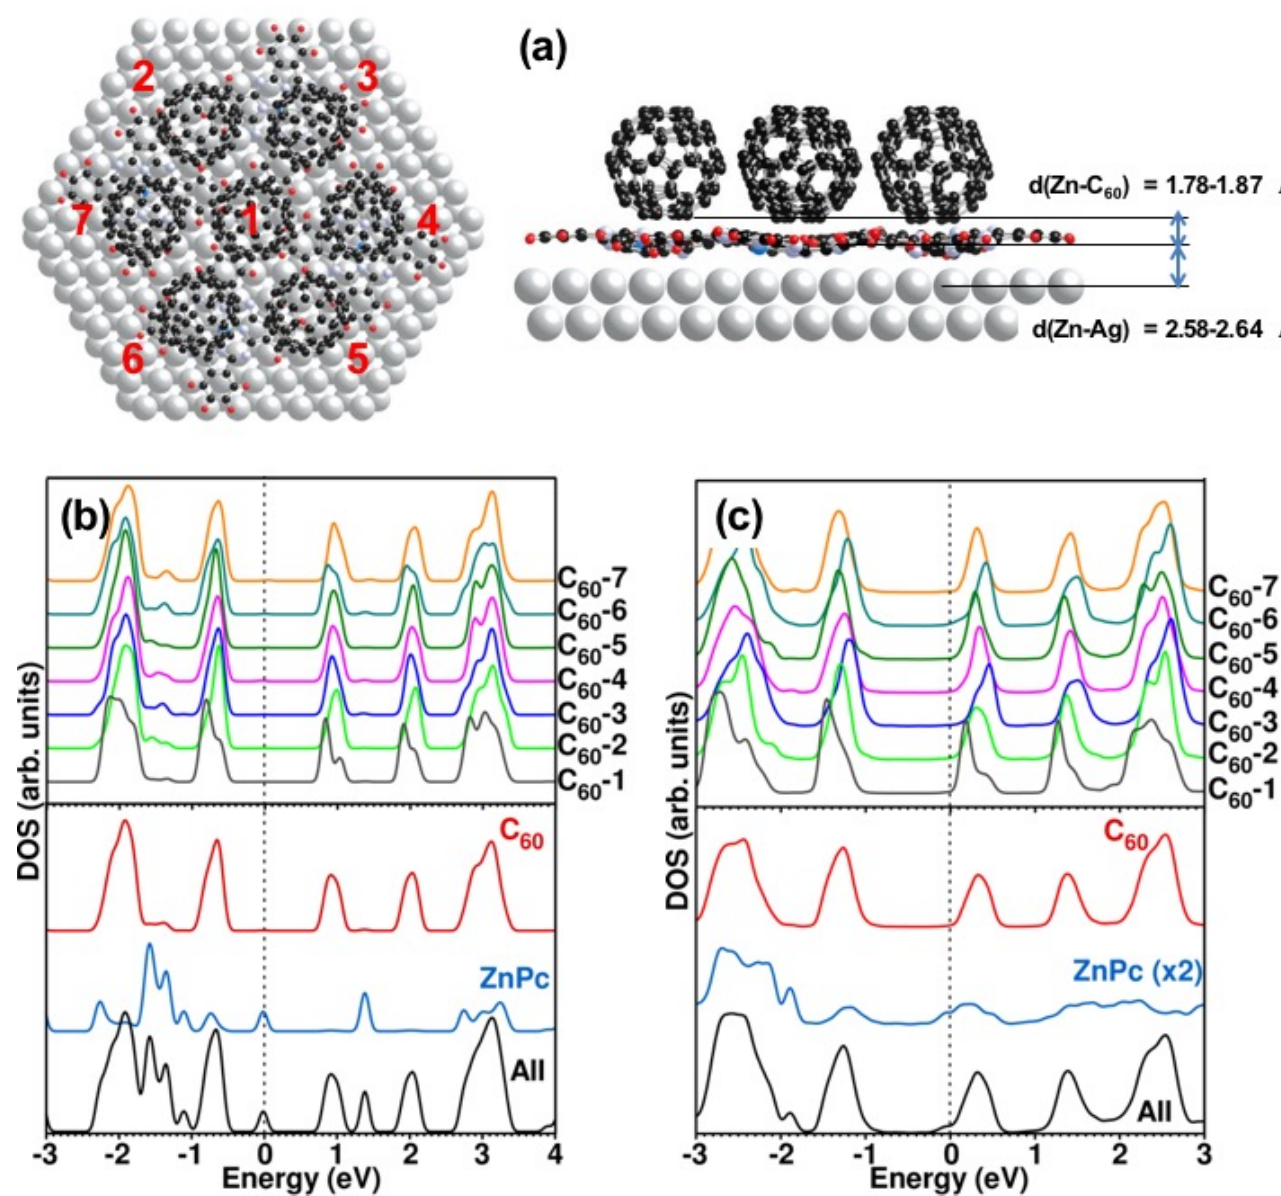
Figure 3. ( a ) 7 C 60 + 4 ZnPc model complex adsorbed on Ag(111) slab used for the DFT calculation. The side view shows the structure of the complex after relaxation. LDOS on the a 7 C 60 + 4 ZnPc model complex ( b ) in the gas phase ( c ) adsorbed on a Ag(111) slab. The LDOS spectra are numbered according to the position of in the complex, C 60 -1 being in the center whereas C 60 -2 to C 60 -7 are on the perimeter. The lower panels show total DOS on C 60 , ZnPc and all together. The energy axis represents (E − E F ).